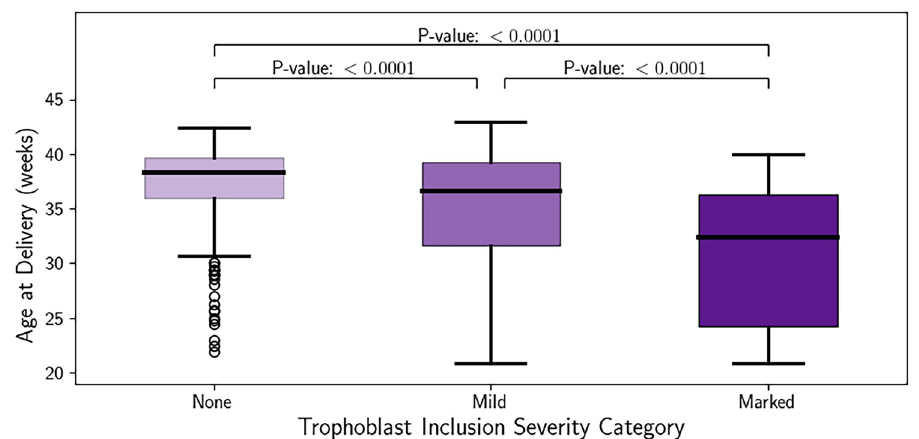
Fig 3. Earlier delivery as a function of TI frequency. Whisker plot of the gestational age at delivery compared to trophoblast inclusion severity category. None (average of 0 TIs per slide), Mild (average of > 0–5 TIs per slide), Marked (average of > 5 TIs per slide).